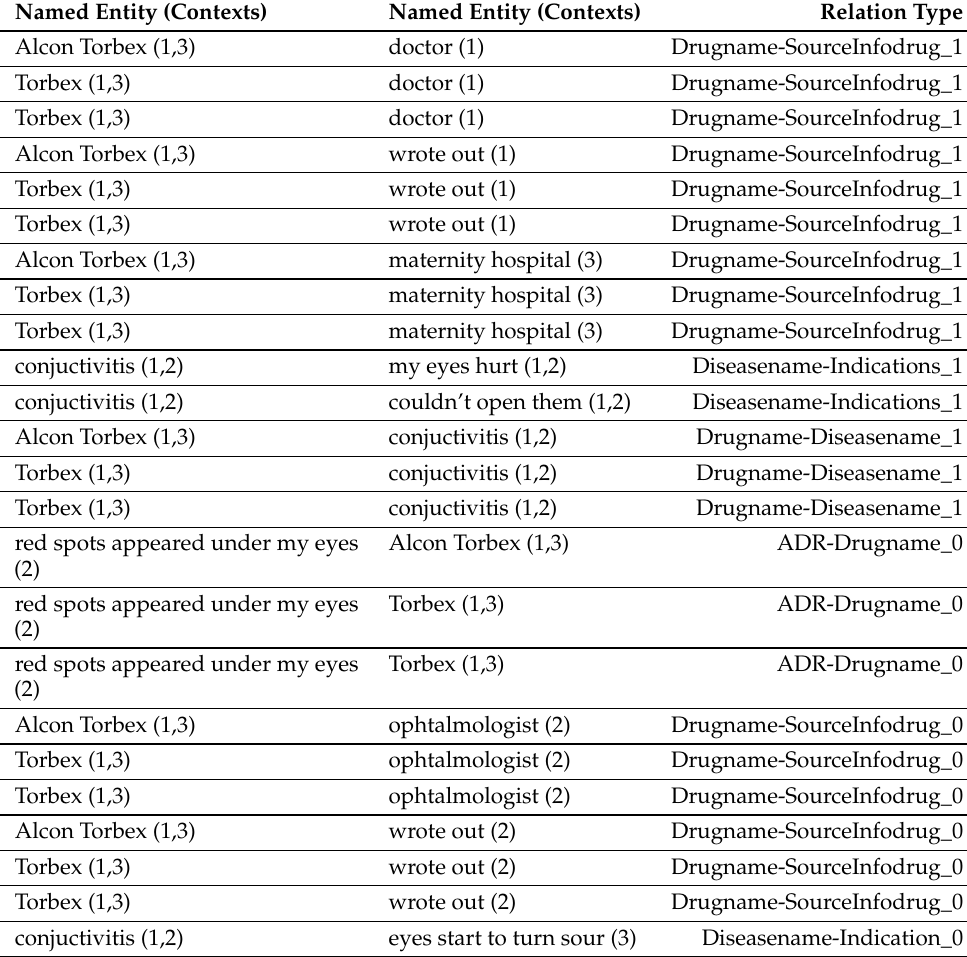
Table 1. Examples of entity relationships based on context annotation.